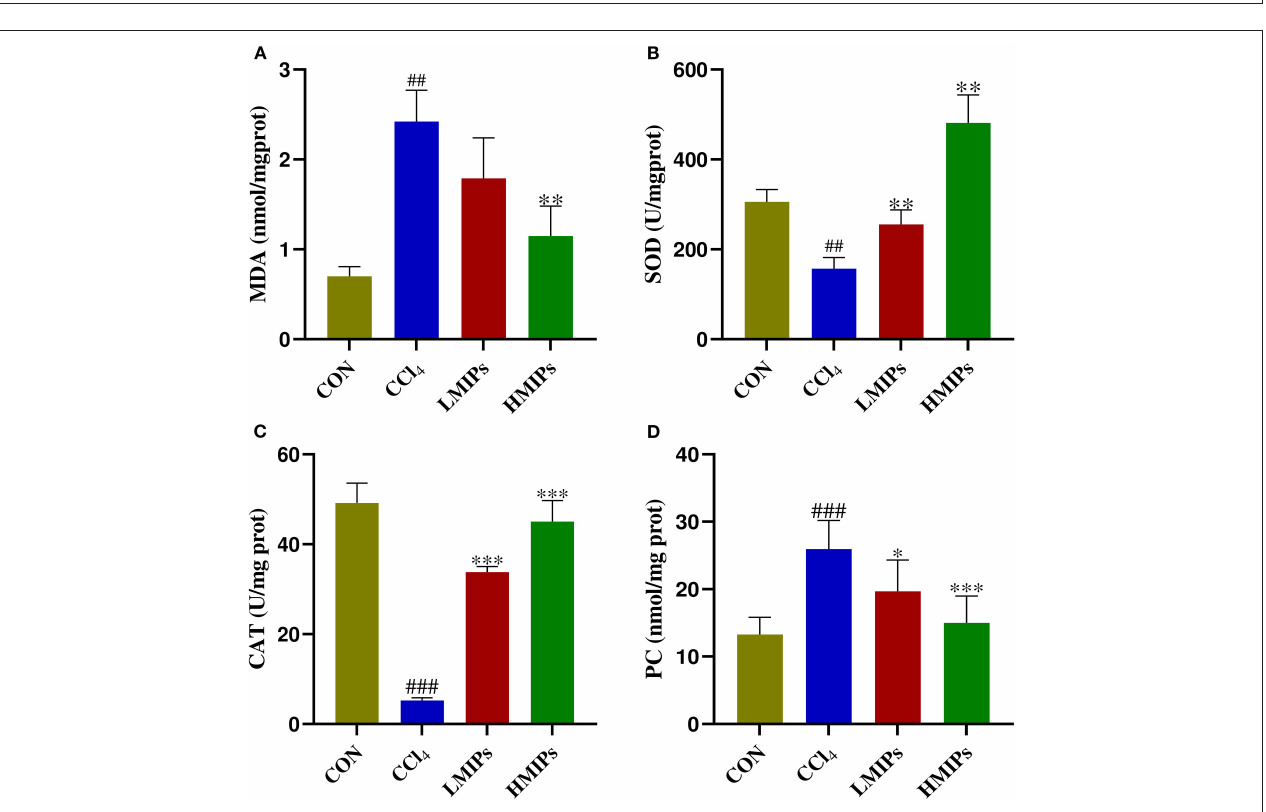
FIGURE 4 | Effect of MIP infusion on hepatic antioxidant activity. The content of hepatic malonaldehyde (A) , superoxide dismutase (B) , catalase (C) , and protein carbonyl (D) was determined by ELISA kits. The values are reported as the mean ± SD of six mice per group: (#) P < 0.05 compared with the control group, (##) P < 0.01. (*) P < 0.05 compared with the CCl4-treated group, (**) P < 0.01 and (***) P < 0.001.